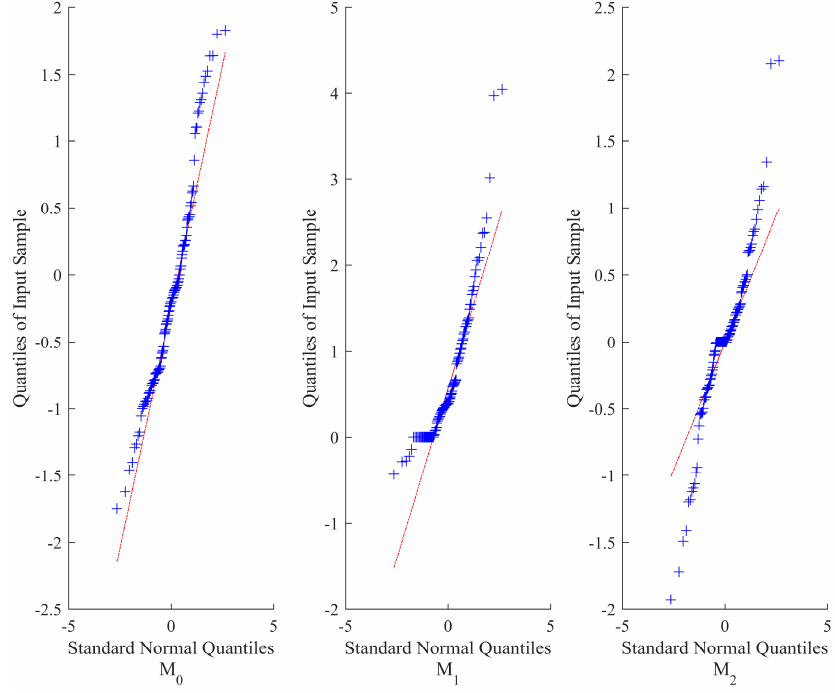
Figure 6. The Q-Q plots for three candidate models for the LED data.